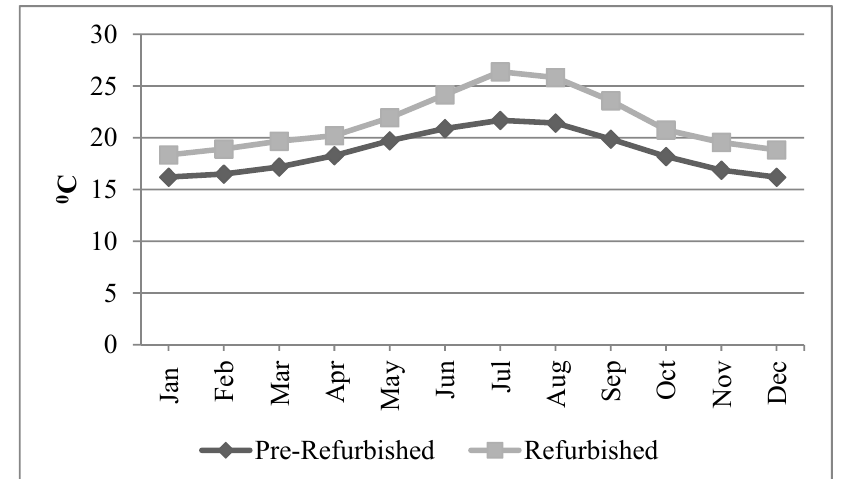
Figure 9. Monthly mean operative temperature (°C) from pre and post-refurbished house under current weather conditions